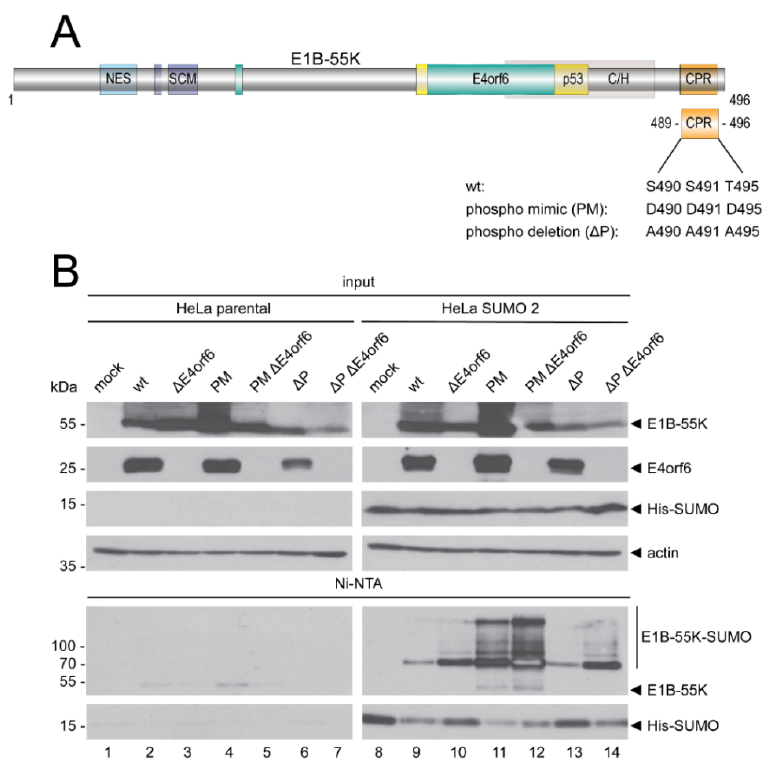
Figure 3. E4orf6 does not target E1B-55K phosphorylation to reduce E1B-55K SUMOylation. ( A ) Schematic overview of the HAdV-C5 E1B-55K protein. The phospho mimic (PM) and phos- pho deletion ( ∆ P) mutants with amino acid exchanges in the C-terminal phosphorylation region (CPR). Here, indicated serine (S) and threonine (T) residues are either exchanged by aspartic acid (D; PM), constantly mimicking phosphorylation, or alanine (A; ∆ P), abrogating E1B-55K phospho- rylation. NES, nuclear export signal. SCM, SUMO conjugation motif. The turquoise E4orf6- and the yellow p53-boxes indicate the respective essential binding regions of these proteins to